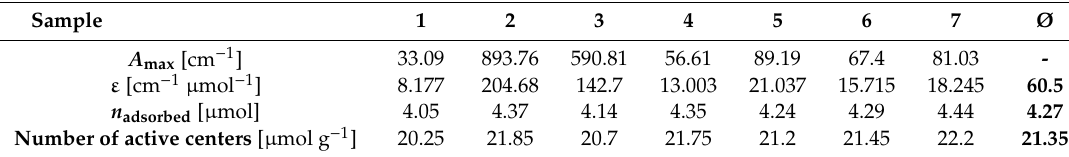
Table 1. Evaluation results of the adsorption of n -butane on SZ.